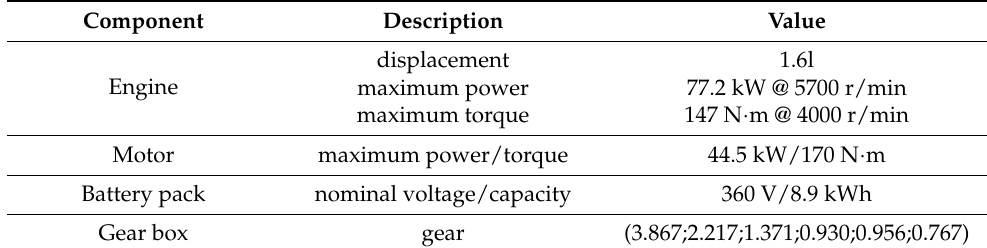
Figure 1. Schematic diagram of the PHEV drivetrain. Table 1. Basic parameters of the PHEV powertrain.